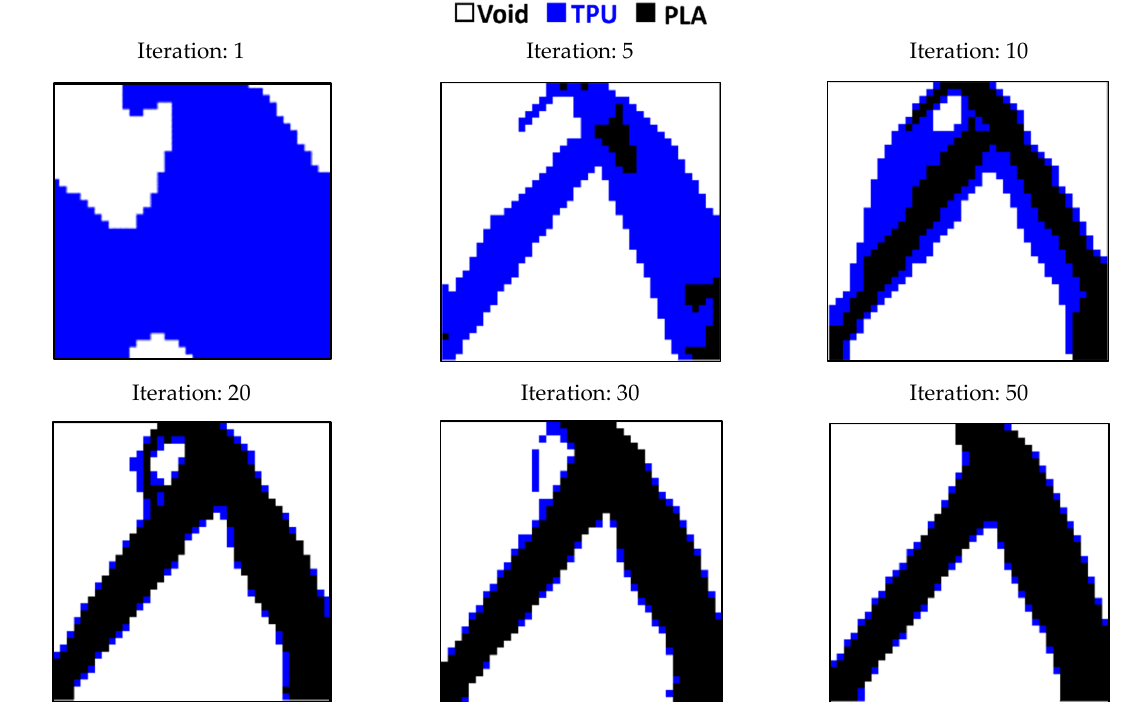
Polymers 2023 , 15 , x FOR PEER REVIEW Figure 9. The Optimization of a square plane with multiple materials. Figure 9. The Optimization of a square plane with multiple materials.